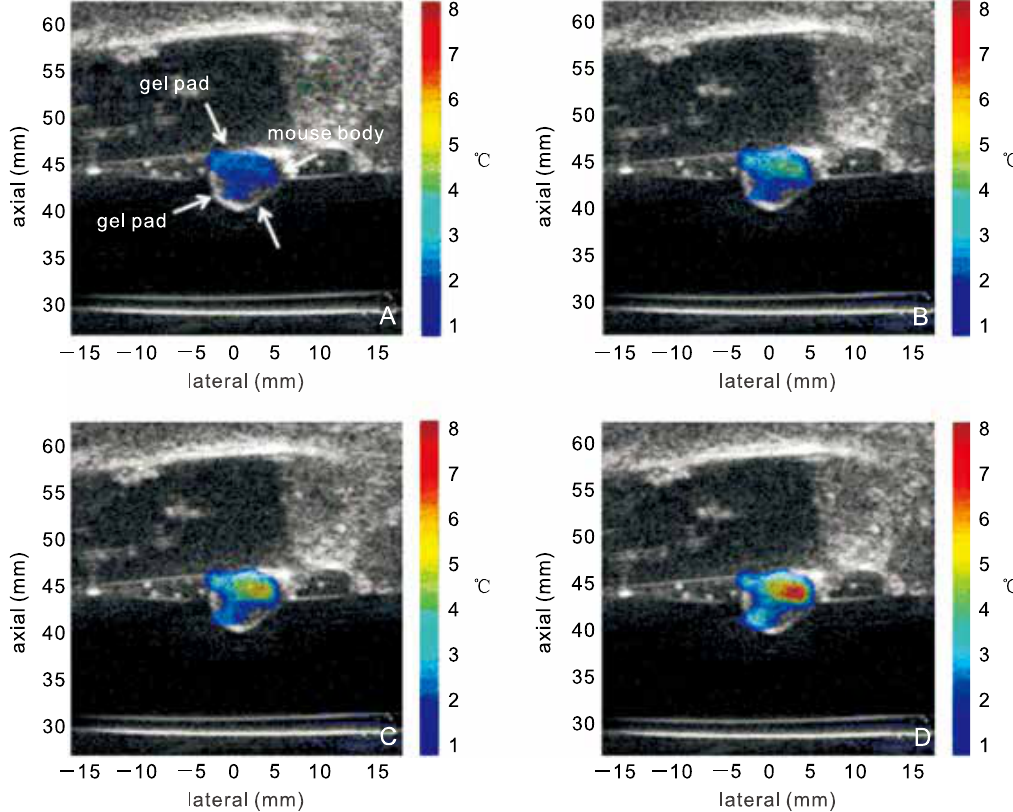
Figure 6 Real-time thermal strain imaging of the tumor (marked with the white arrows) treated with mild hyperthermia: temperature elevation map superimposed on B-mode image 30 s (A), 60 s (B), 90 s (C) and 120 s (D) after heating